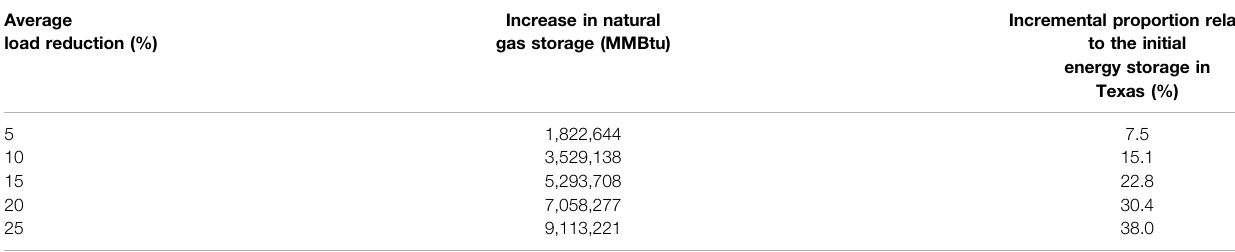
TABLE 2 | Effect of average load reduction on natural gas fuel